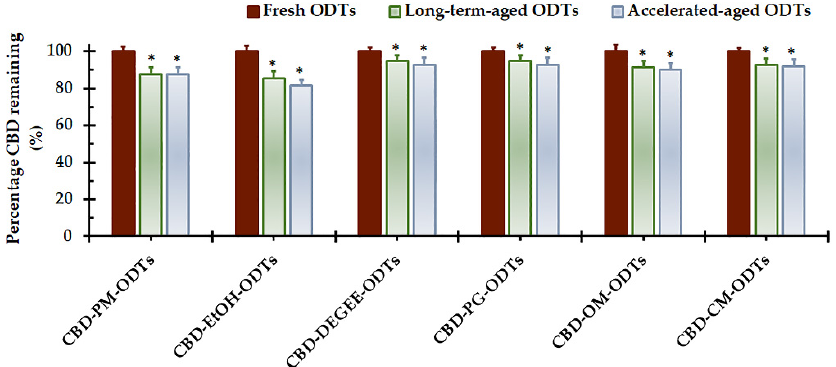
Figure 4. Percentage of remaining CBD in CBD ODTs stored under long-term (5 ± 3 ◦ C) and accelerated (30 ± 2 ◦ C/75 ± 5% RH) conditions for 4 months (mean ± SD, n = 3). The CBD ODTs were composed of 8% SSG and compressed under a sufficient compression pressure (3–4 MPa) to yield tablets with a hardness of 31 ± 2 N. * Significant decrease as compared to the fresh CBD ODTs ( p < 0.05).